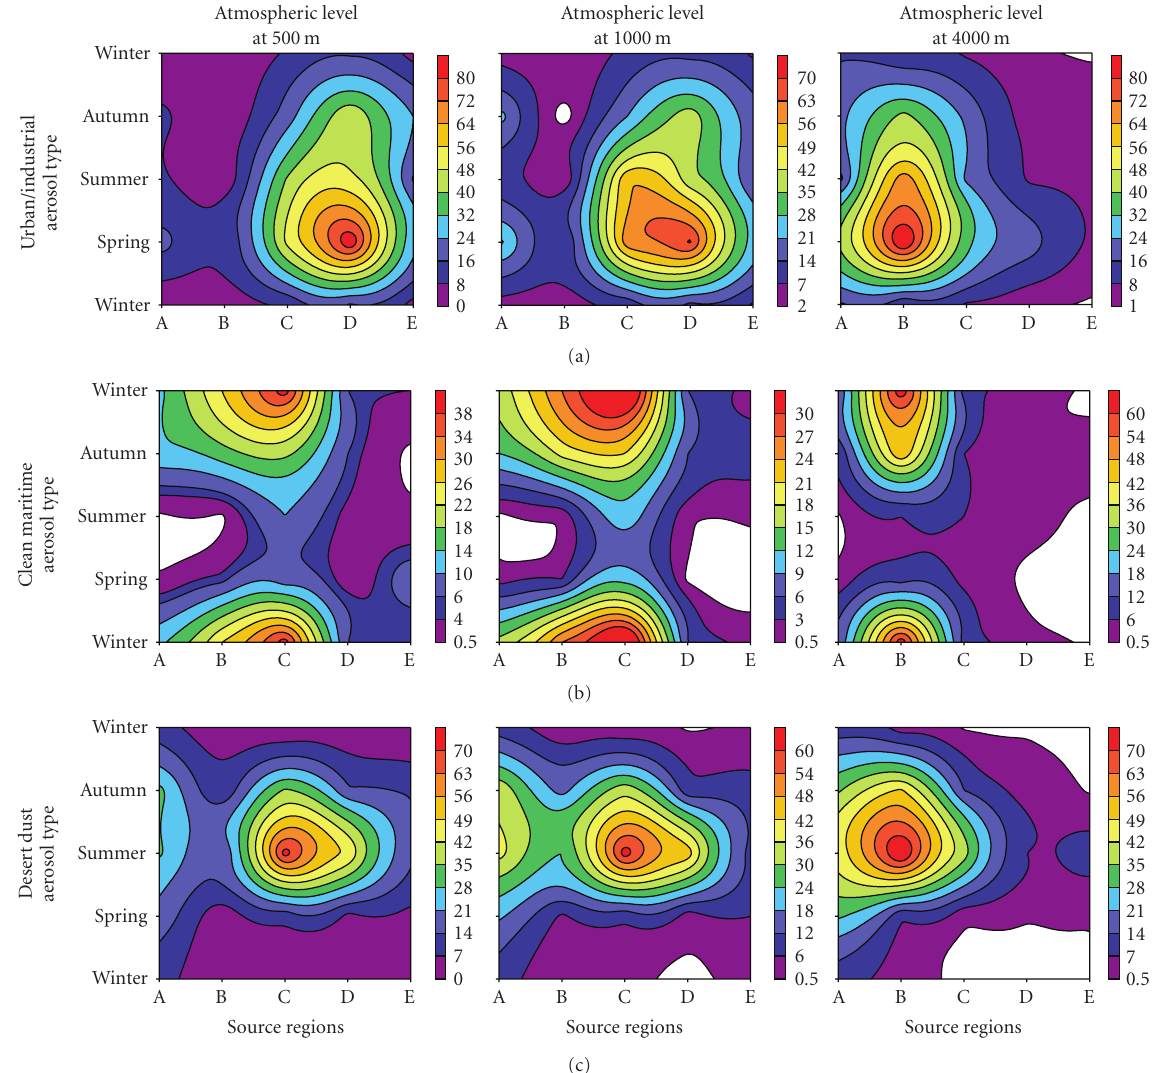
Figure 9: Contour plot of the seasonal frequency distribution of the air-mass trajectories at three atmospheric levels over GAA for all aerosol types. The white gaps correspond to lack of